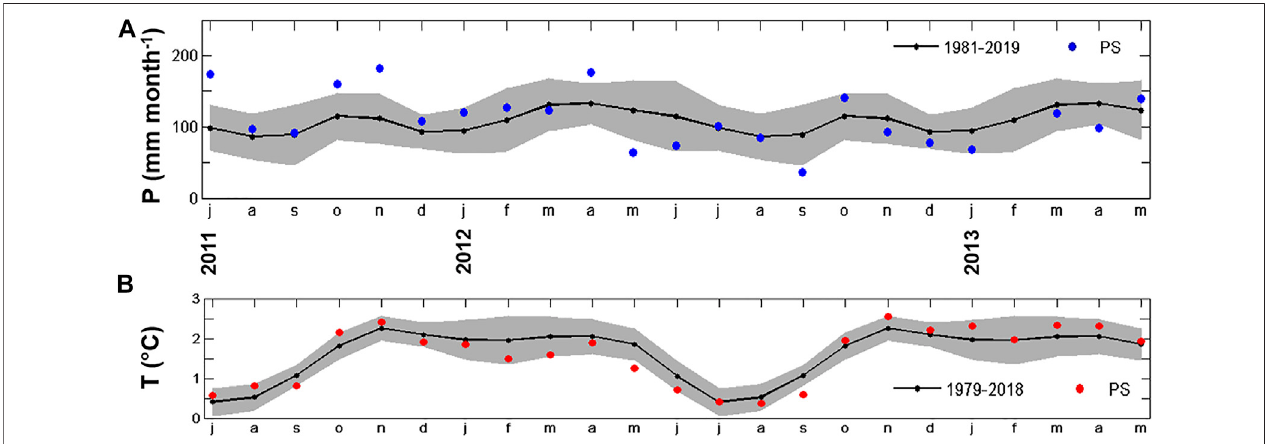
FIGURE 4 | (A) Monthly CHIRPS precipitation (0.05 ° × 0.05 ° ) values for the study period (blue circles) relative to mean CHIRPS precipitation for 1981 – 2019 period (blackcircles)andmonthlystandarddeviations(grayshading)forthegridpointnearestAntisana12Glacier(78.15 ° W,0.45 ° S). (B) MonthlyERA5airtemperature(0.25 ° × 0.25 ° ) at 600 hPa level, averaged over the Antisana massif region (0.2 to 0.8 ° S, 77.8 to 78.5 ° W) for the sudy period (red circles) relative to mean ERA air temperature for 1979 – 2018 period (black circles) and monthly standard deviations (gray